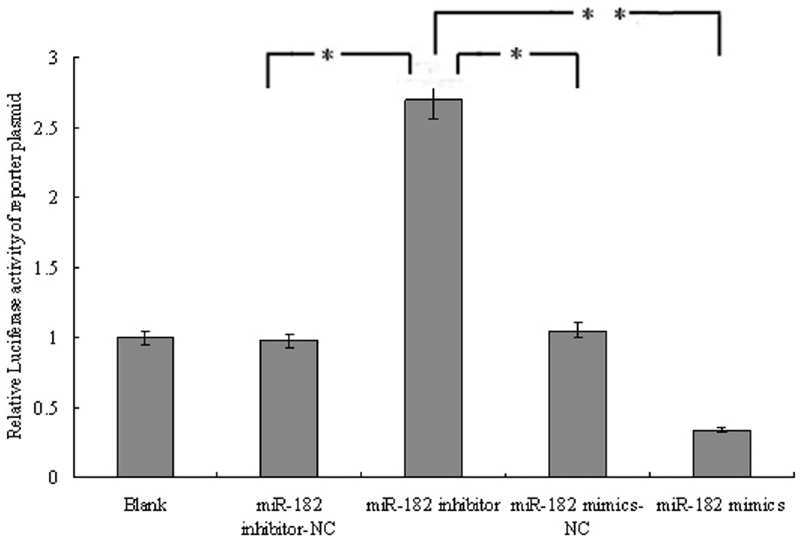
Figure 11. Relative luciferase activity of the pmirGLO/NDRG1-UTR in PC-3 cells. Luciferase activity of the pmirGLO/NDRG1-UTR was dramatically inhibited in miR-182 mimics group and significantly increased in miR-182 inhibitors group, compared to the control groups (* P , 0.05, ** P , 0.01).